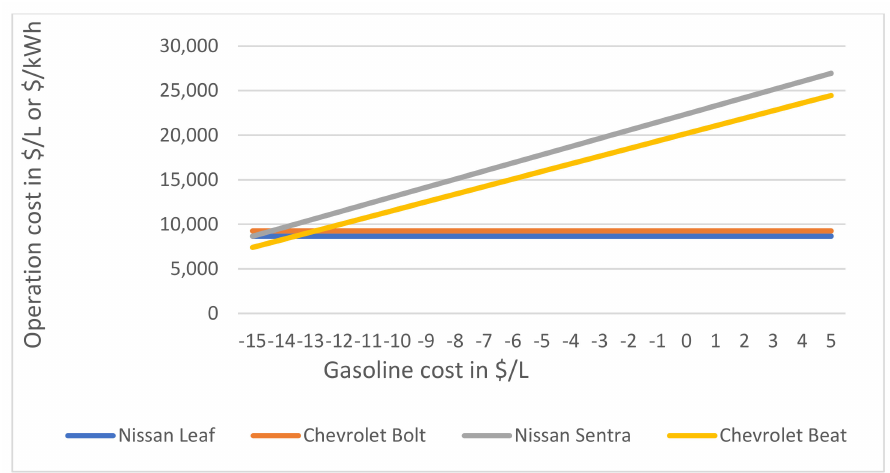
Figure 7. Operation cost with gasoline price variations with the electricity cost fixed at USD 0.05/kWh.